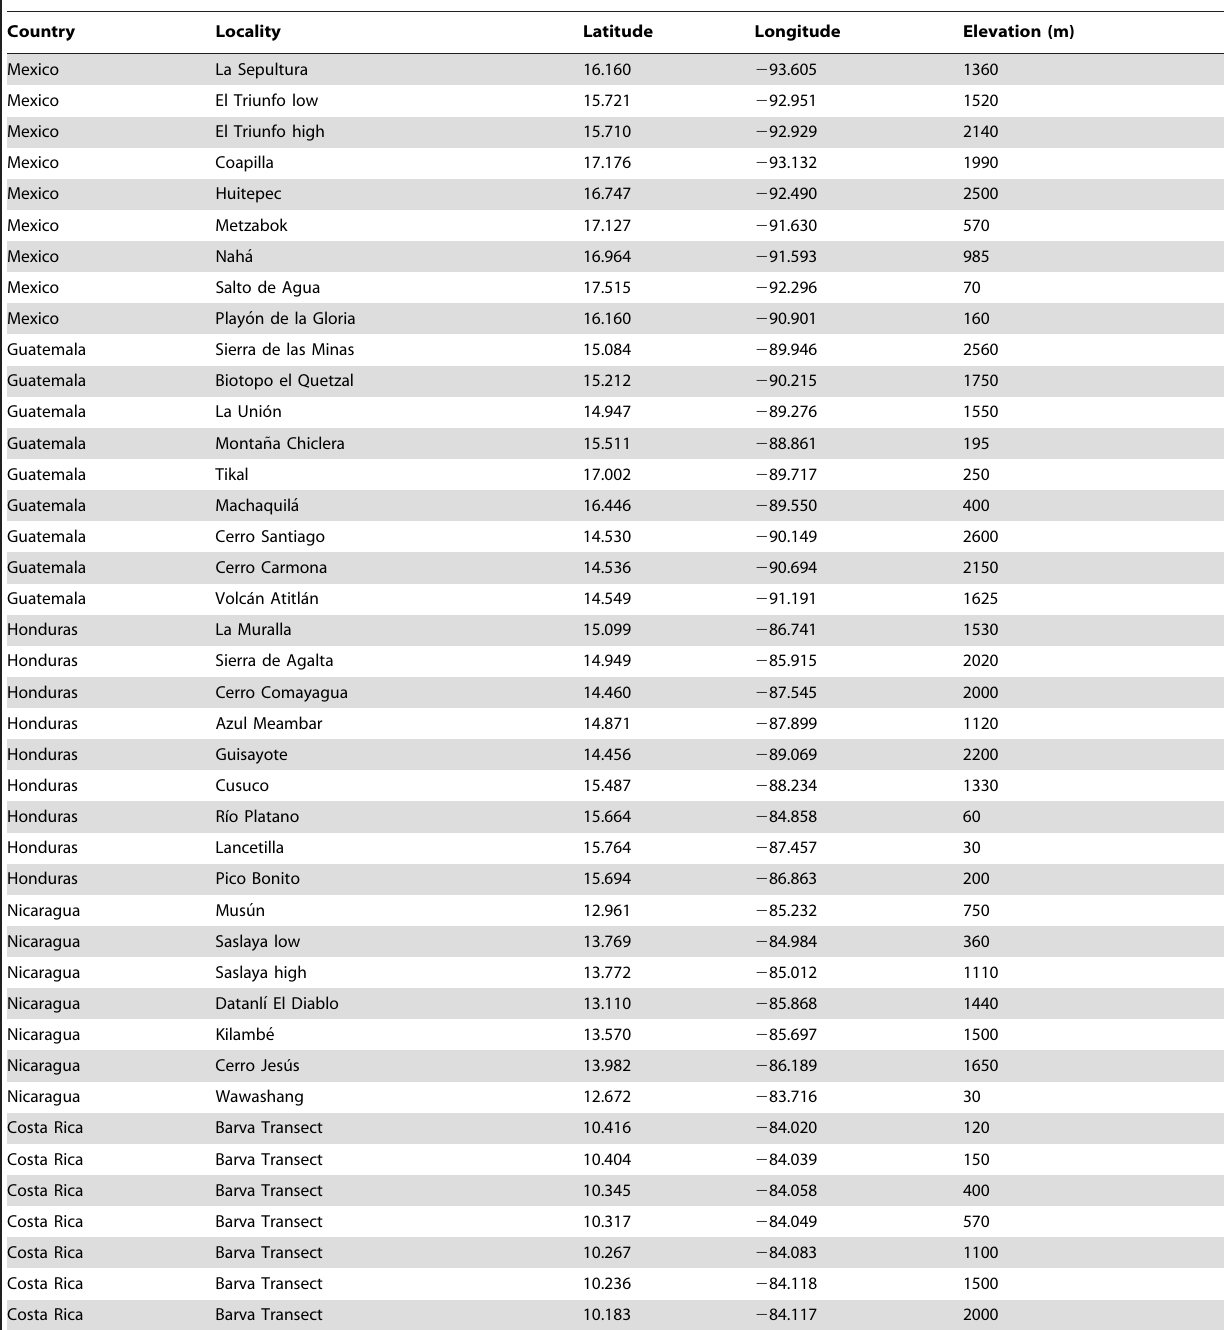
Table 1. Sample sites for leaf litter ants in Central